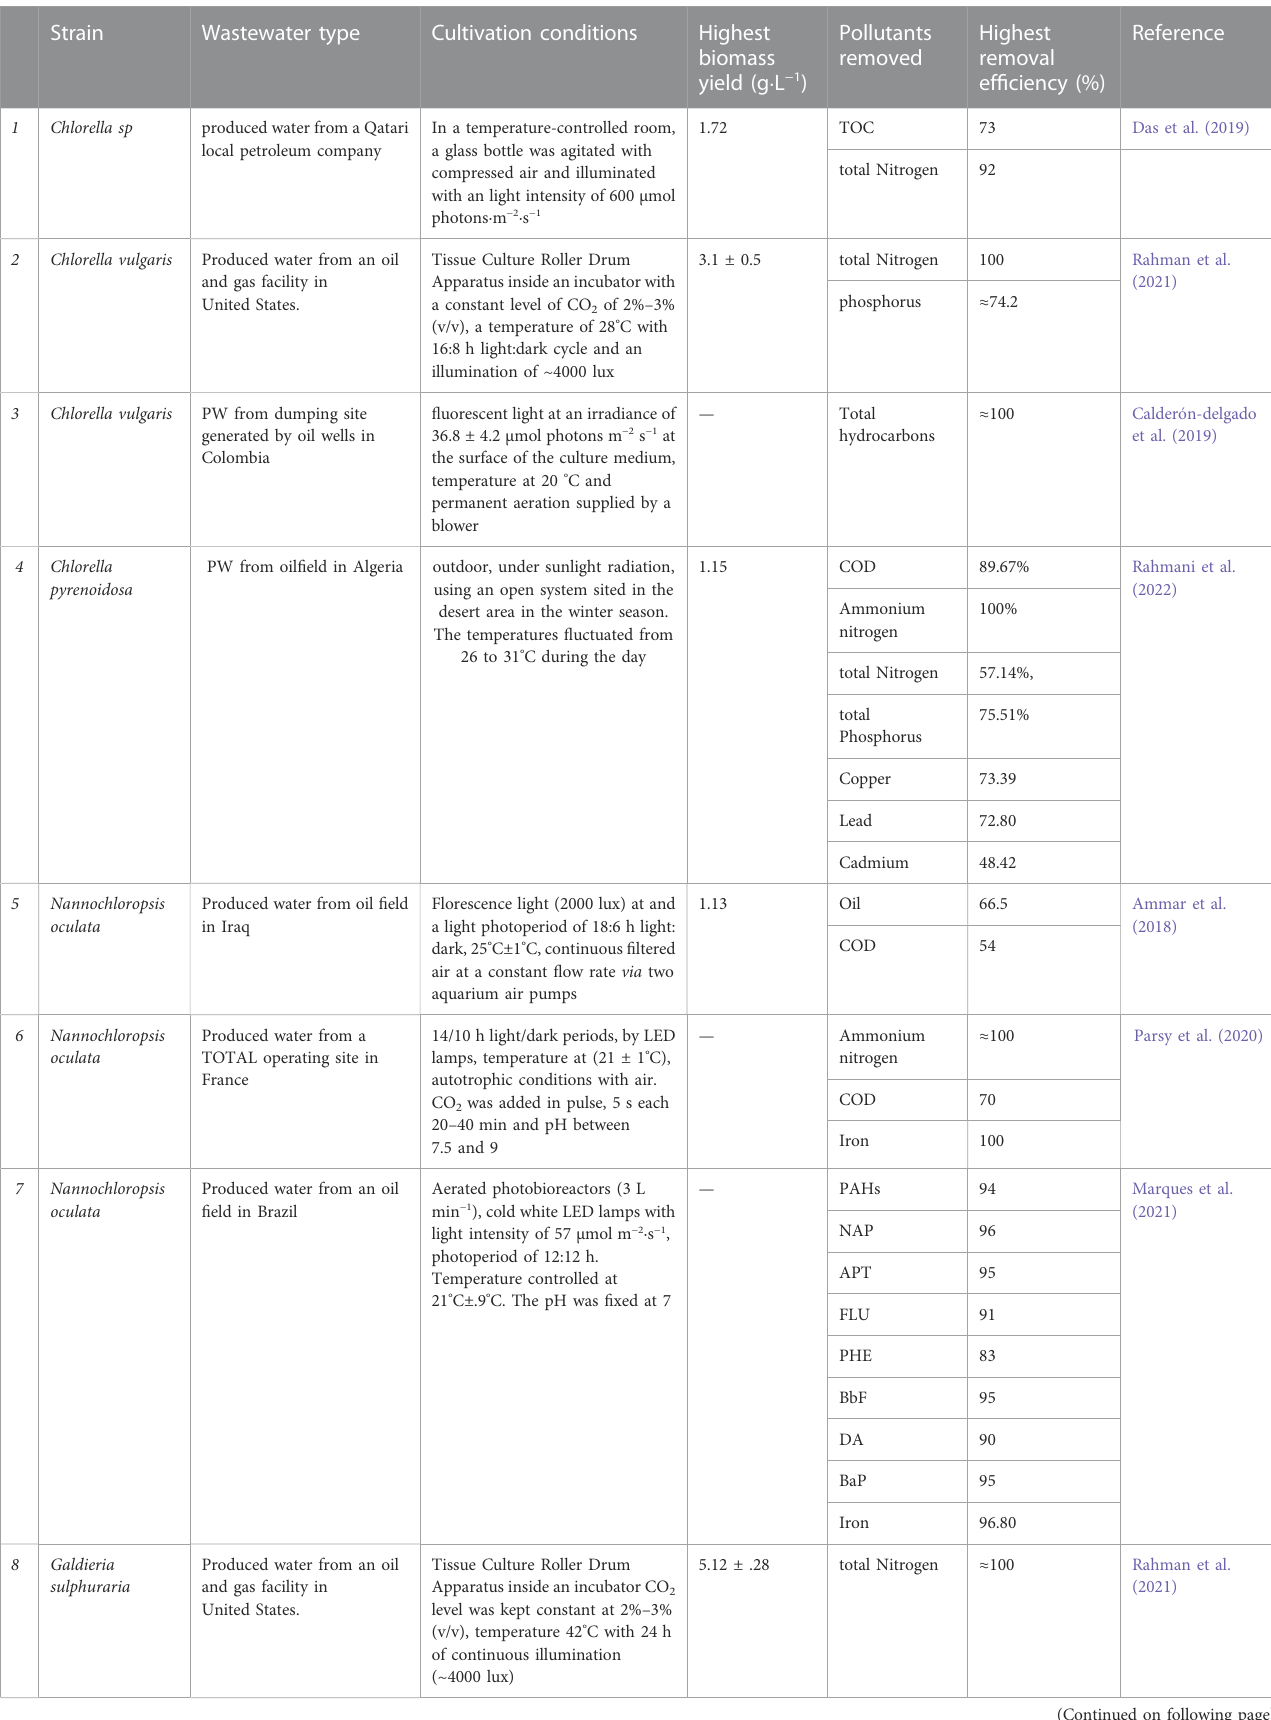
TABLE 1 Selected recent literature on algal bioremediation of